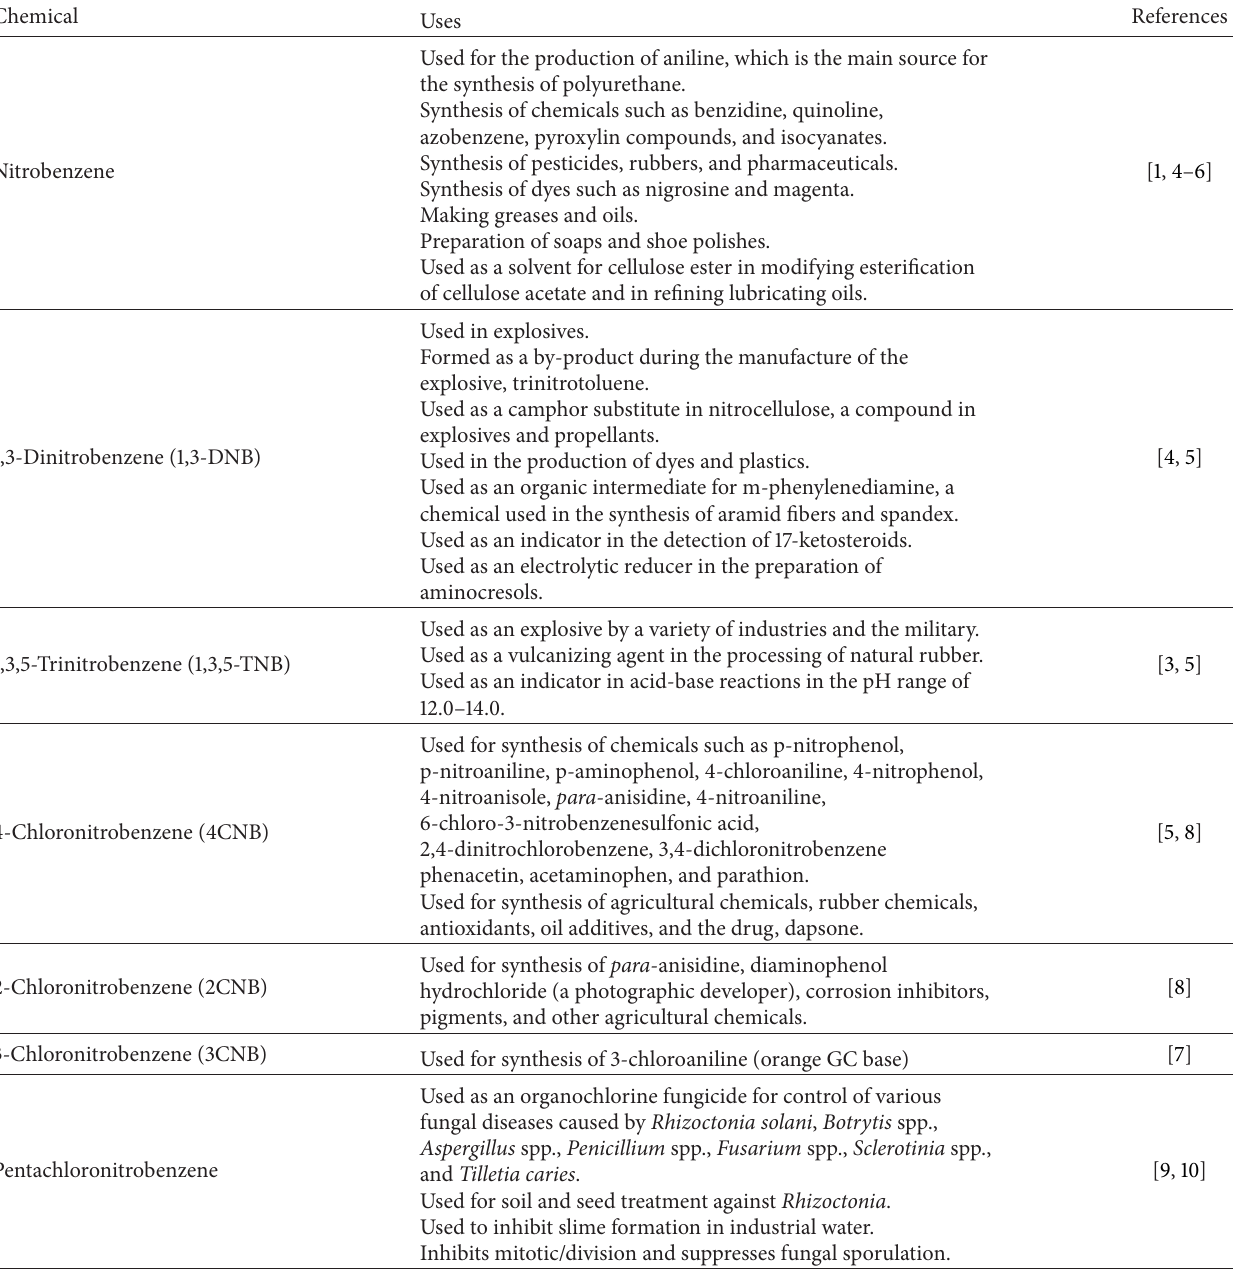
Table 1: Uses of nitrobenzene and its